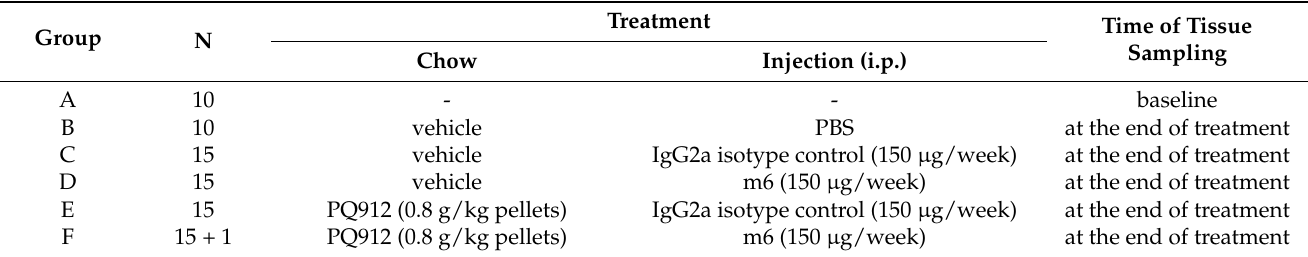
Table 2. Overview on treatment groups in the combination